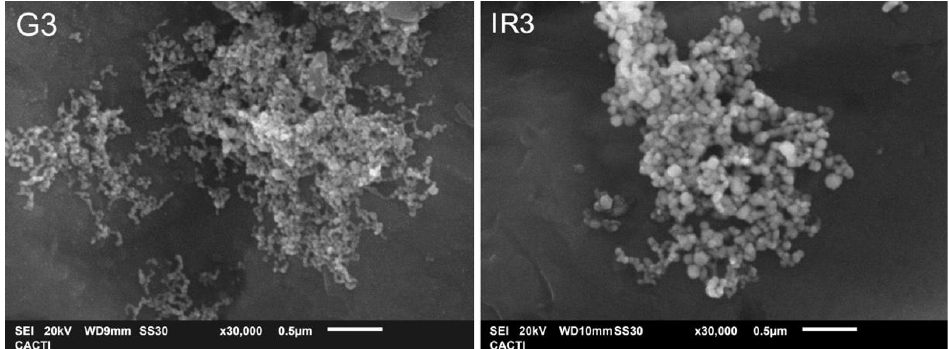
Figure 8. FESEM micrographs of titanium discs with immobilized Ag nanoparticles obtained in water by laser ablation after three re-irradiations with: ( G3 ) Green-nanosecond laser, and ( IR3 ) IR-picosecond laser.